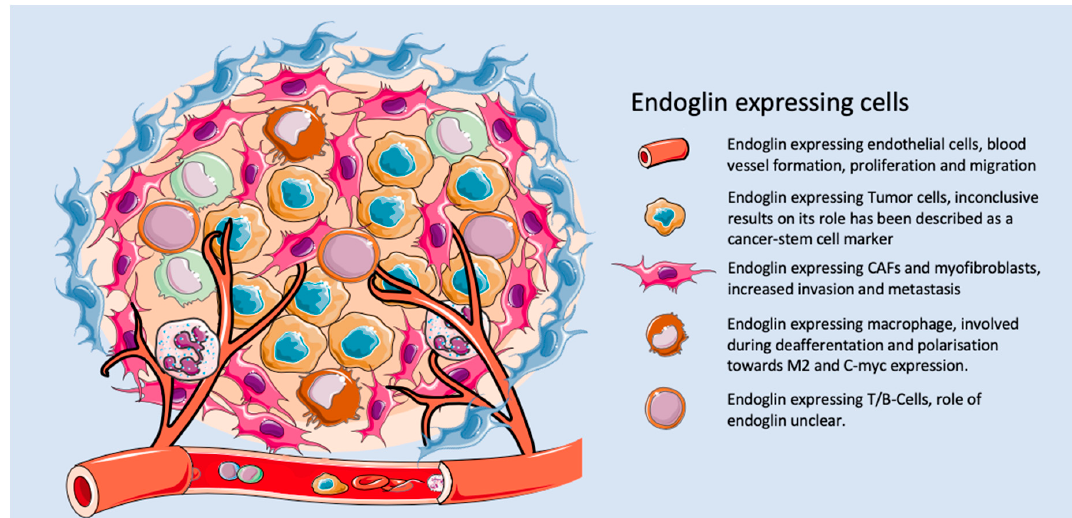
Figure 2. The role of endoglin on different cell types within the tumor microenvironment.